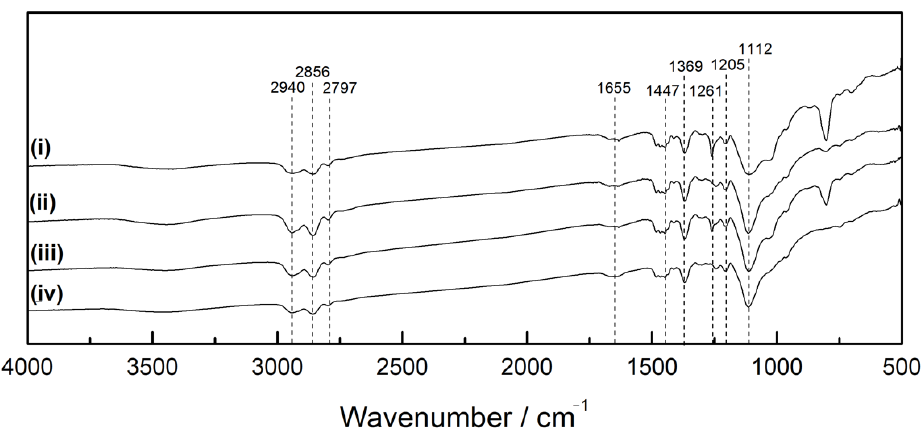
Figure 5. FTIR spectra of A(170)_ 3b OIH sol–gel matrices: (i) A(170)_ 3b @500; (ii) A(170)_ 3b @600; (iii) A(170)_ 3b @900; (iv) A(170)_ 3b @1000.